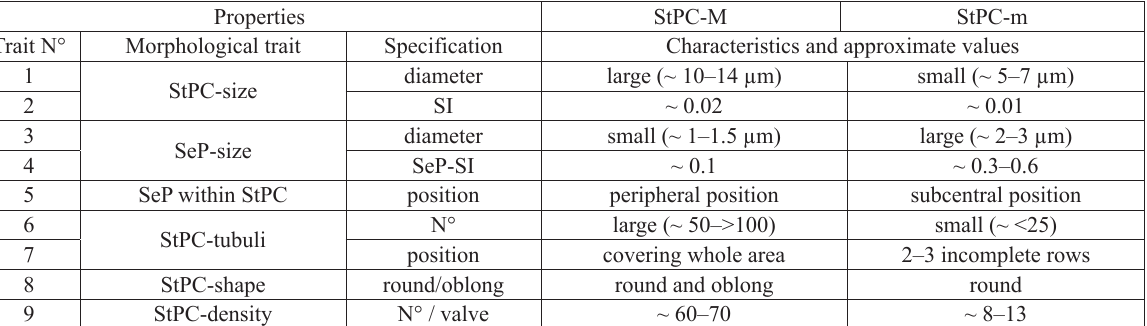
Table 5. Synthesis of sieve-type pore canals-Macro (StPC-M) and sieve-type pore canals-micro (StPC-m) of Minyocythere species. Abbreviations: SI, Size Index; SeP, setal pore of the StPC; SeP-SI, Setal Pore Size Index (ratio of the SeP diameter to the StPC